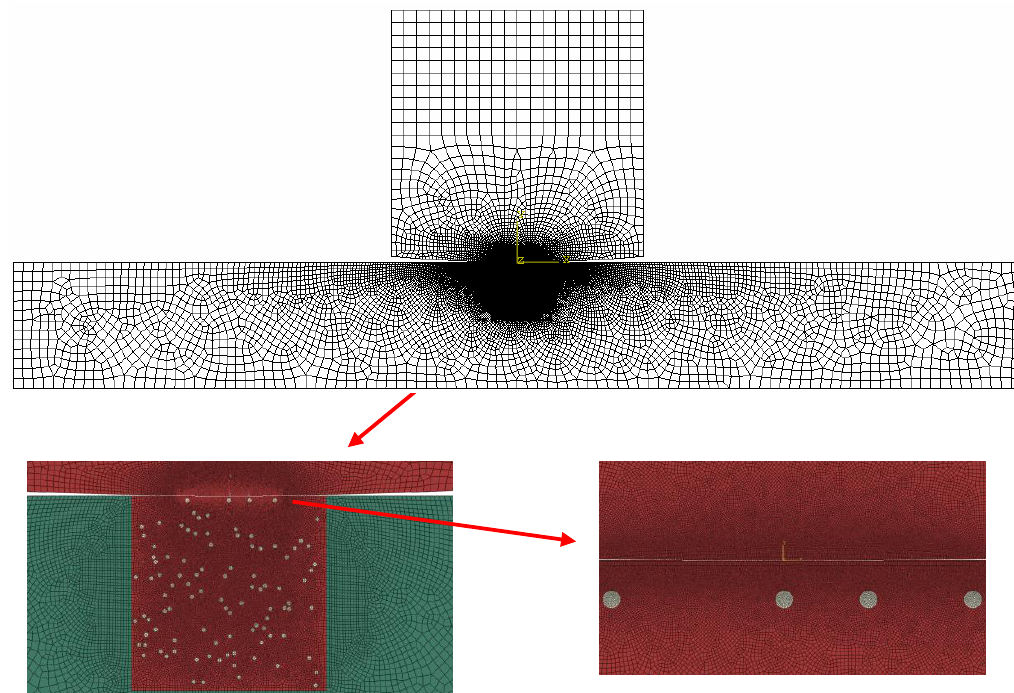
Figure 11. Finite element model of case 3 with artificially placed four inclusions.